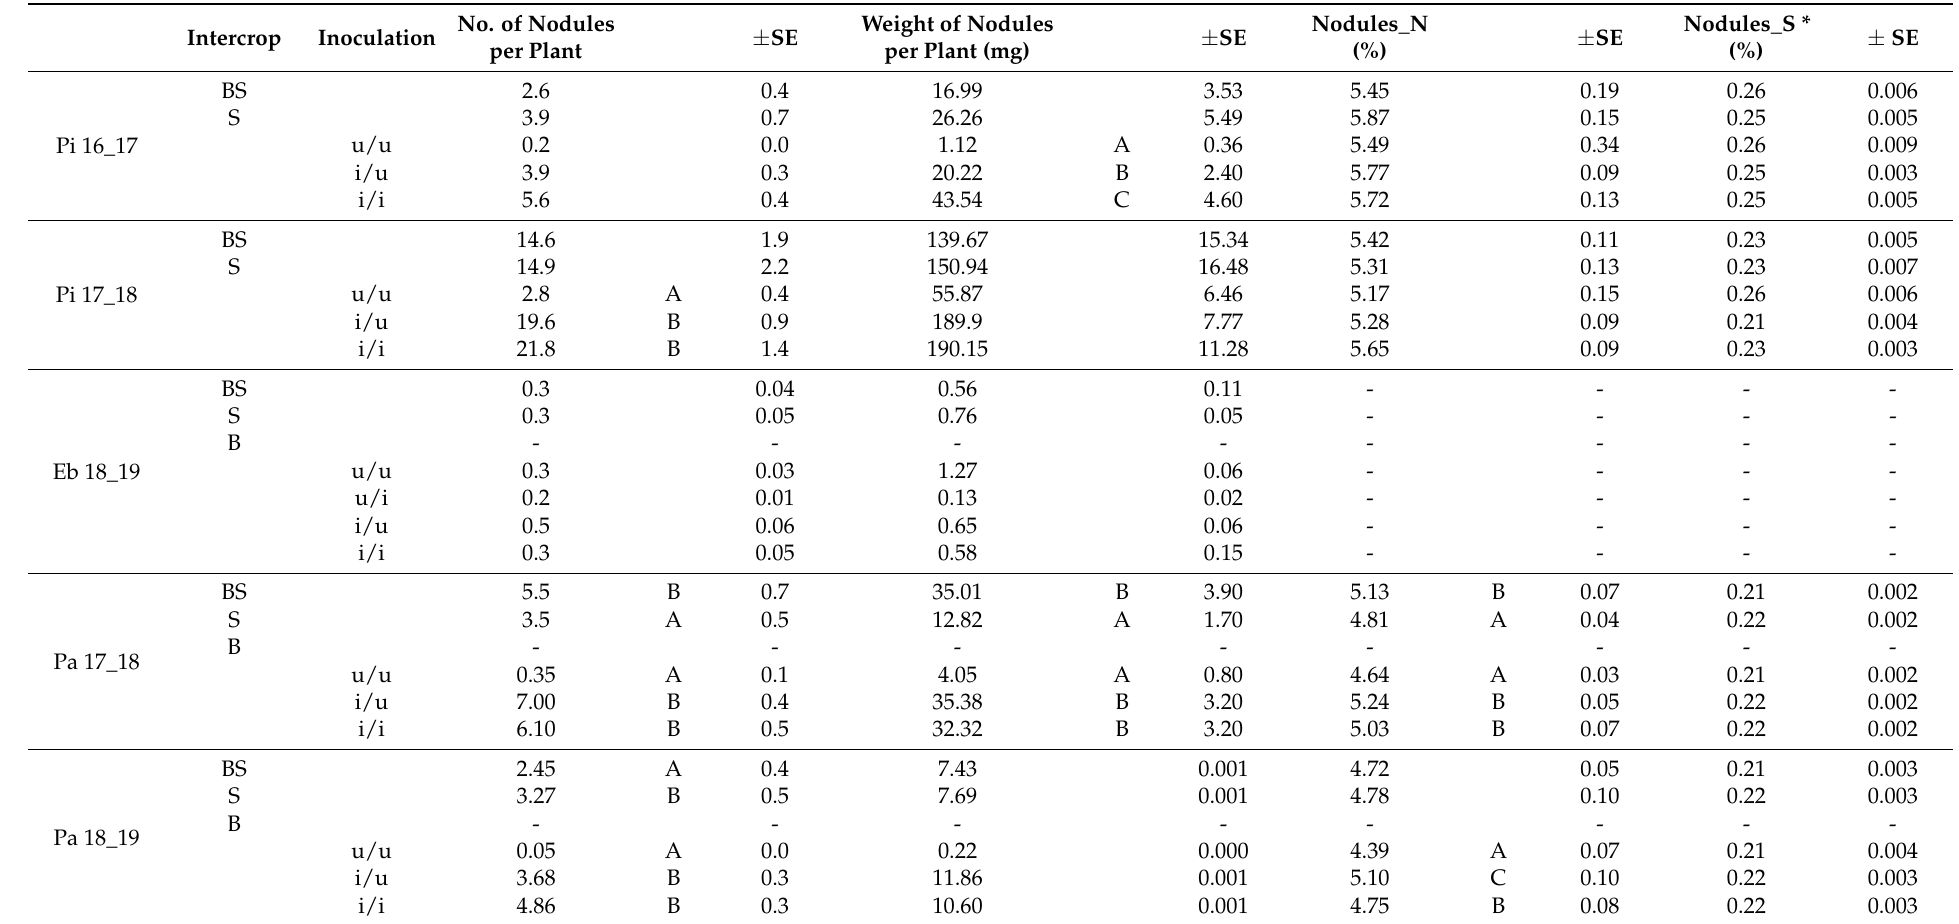
Table 4. Recorded nodule data in soybean